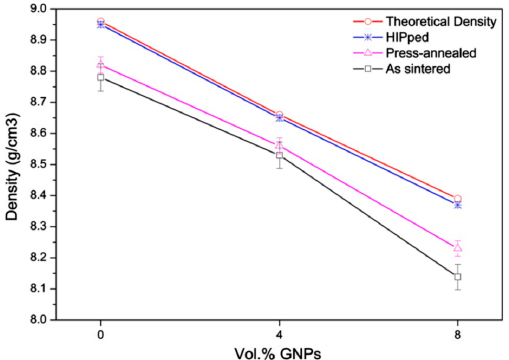
Figure 17. Theoretical and measured densities of composites after sintering and two different post-processing techniques (repressing followed by annealing and HIPing) [10], Reproduced from [10], with permission from Springer Nature, 2018.